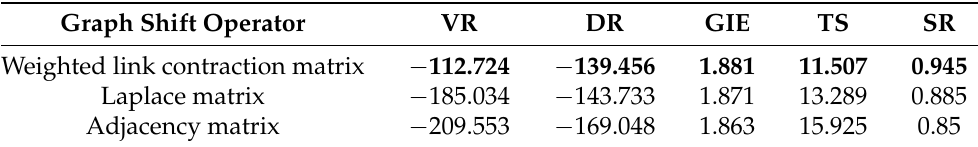
Table 3. Evaluation results of different graph shift operators.